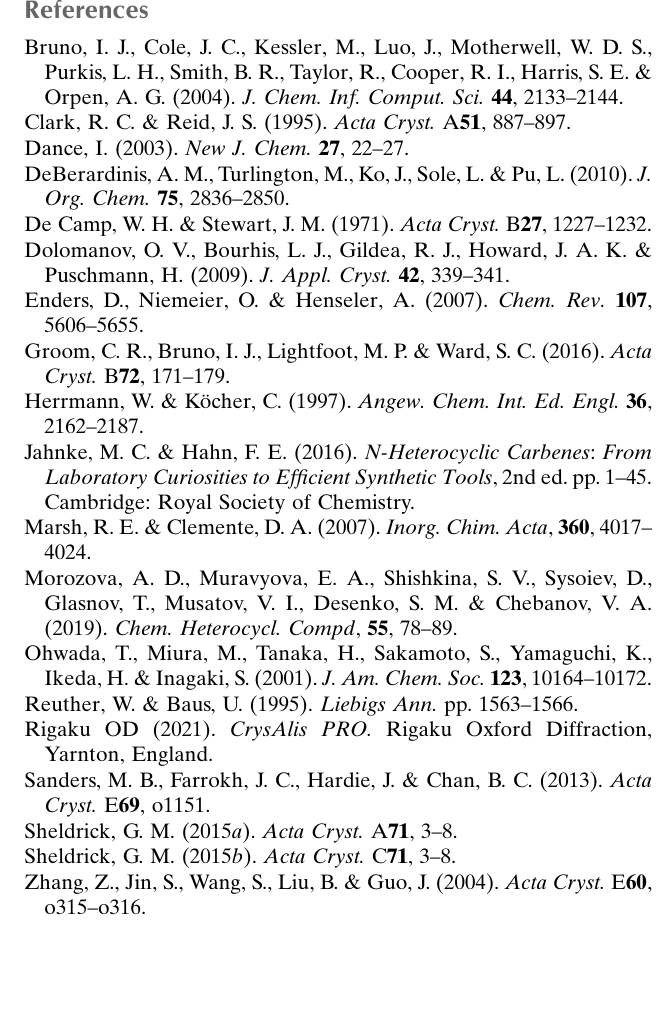
Crystal data Chemical